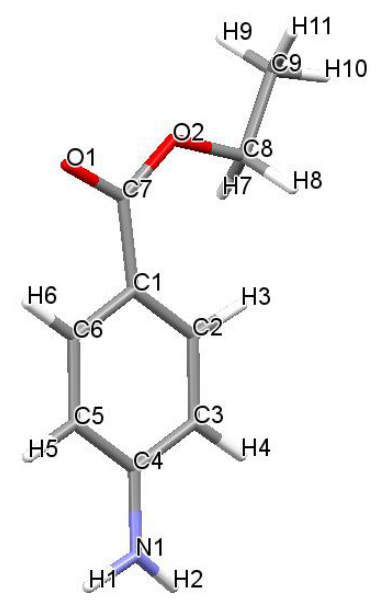
Fig. 13. The optimized crystal structure of benzocaine polymorph generated as Str